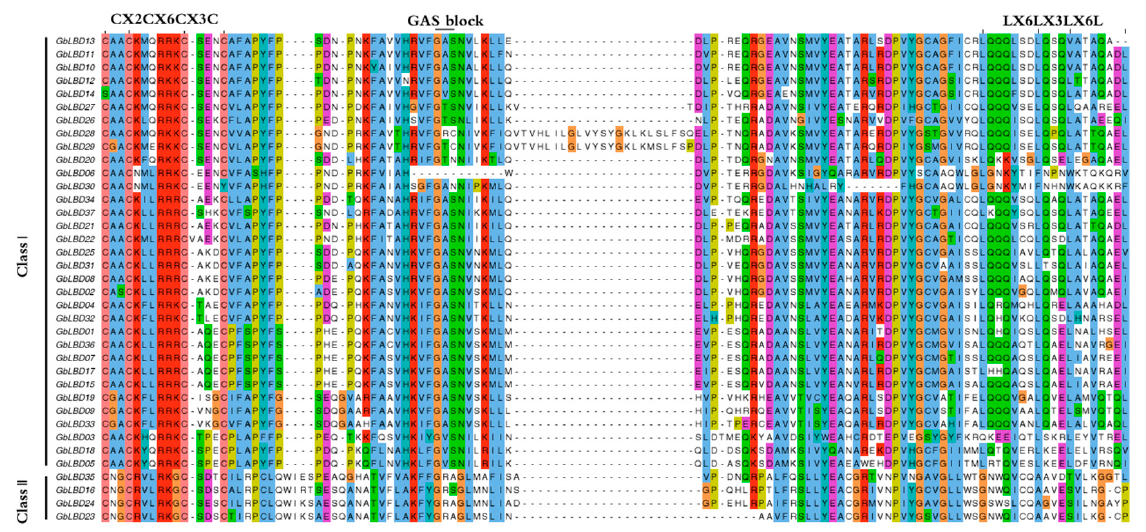
Figure 2. Conserved structural domains of ginkgo GbLBD protein.